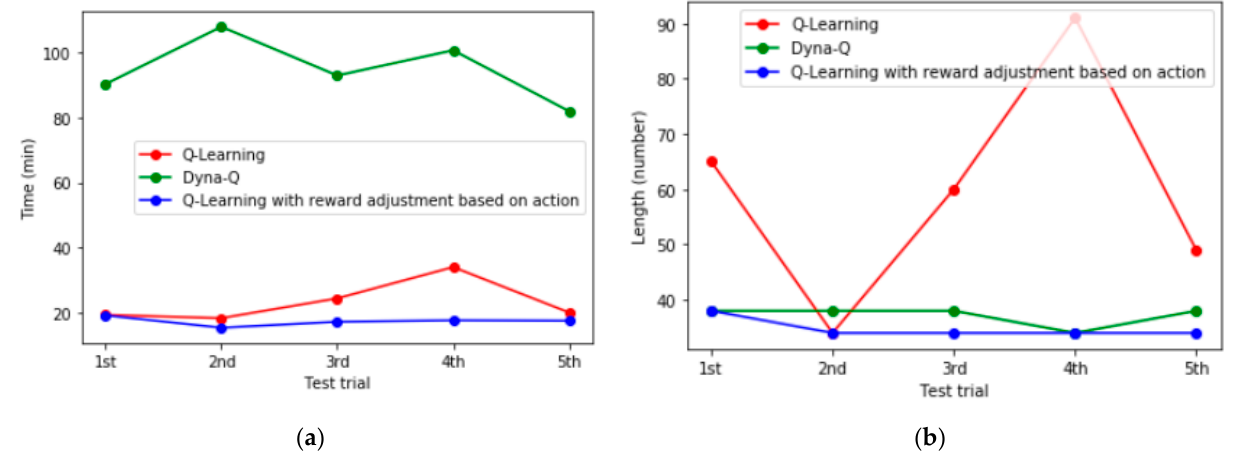
Figure 13. Comparison of experiment results: ( a ) Total elapsed time; ( b ) Length of final path.